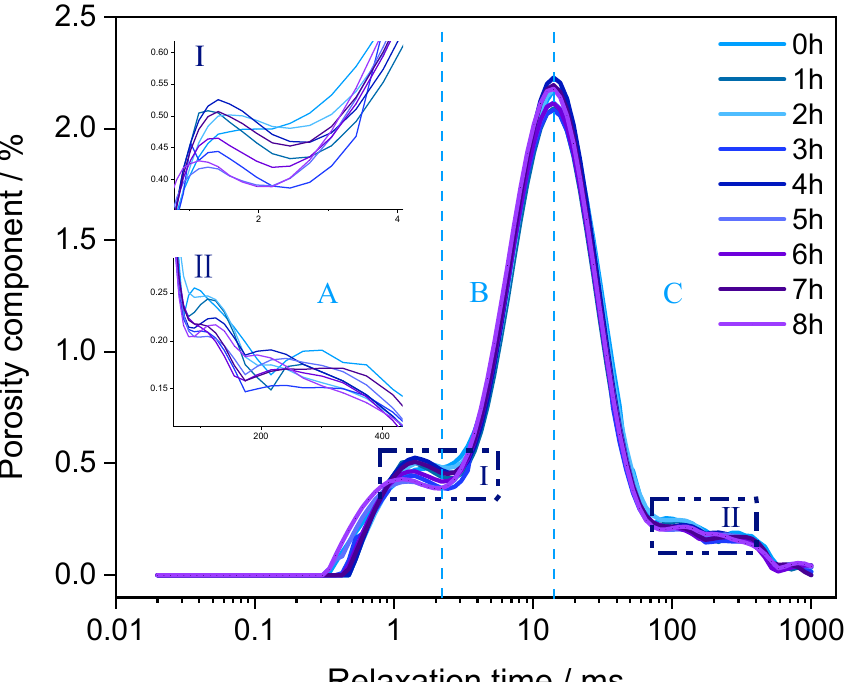
Figure 7. Evolution curve of T2 map in pure H 2 O leaching process.